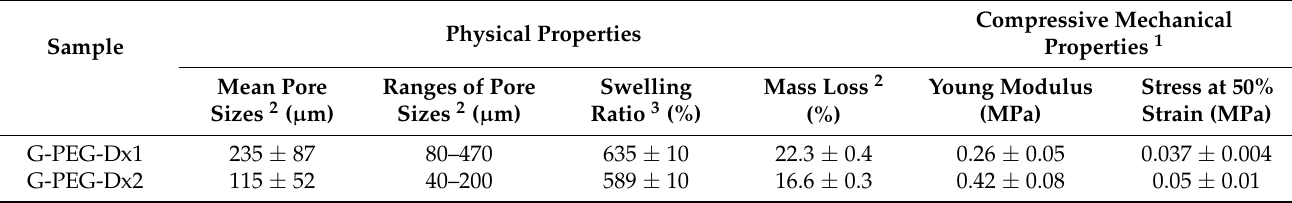
Figure 1. ( A ) Macroscopical morphology of hybrid hydrogels. Optical visualization of pore morphology observed in the hybrid hydrogels. ( B , C ) Hybrid hydrogel interaction with water. Water uptake (%) and mass loss of the hydrogels by immersing them in distilled water at 37 ◦ C up to 28 days. ( D ) Compression behavior of hydrogels. Representative compressive stress–strain curves for hybrid hydrogels in wet conditions. Table 1. Physical-mechanical properties of